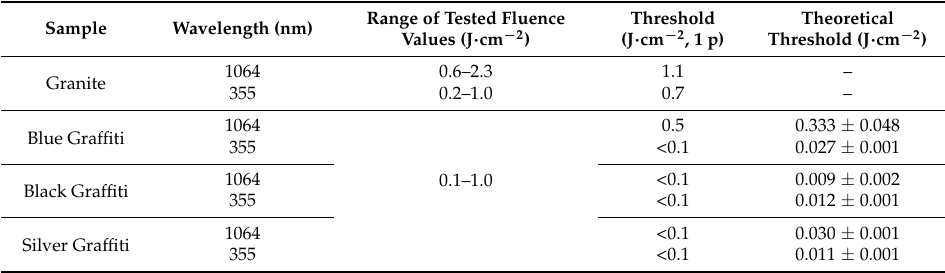
Table 1. Extraction thresholds for the three graffiti paints and damage thresholds for granite at 1064 nm and 355 nm. Range of tested fluences for both wavelengths for the unpainted granite and the graffiti painted glass slabs are also shown together with the calculated theoretical threshold values for the three paints (described in Section